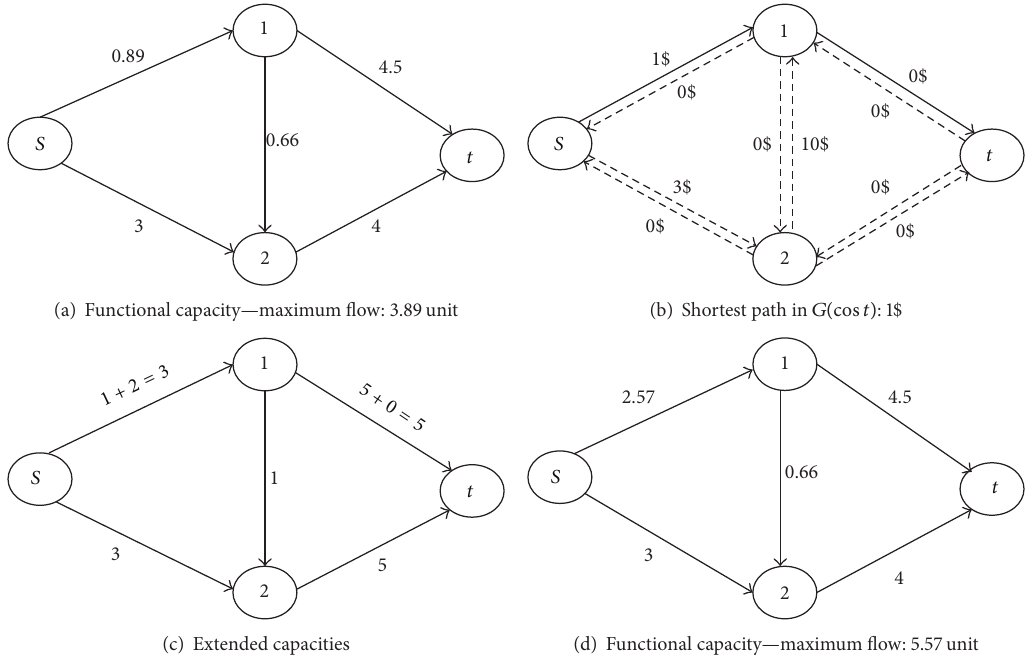
Figure 2: The network after one stage of running CEA using 𝐴 1